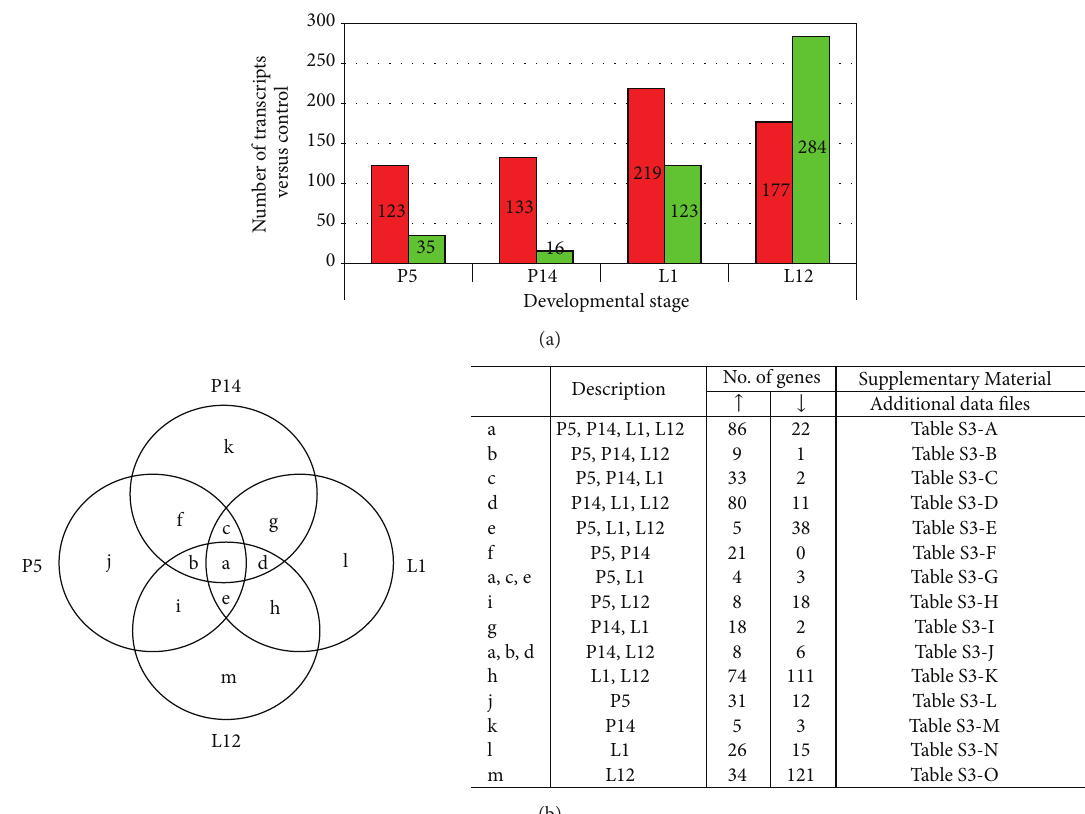
Figure 2: Overview of gene expression during mammary development through early pregnancy to mid-lactation. (a) Number of altered transcripts of each developmental stage versus a virgin stage (fold change ( z -score) > 1.5). Low expression is represented by green and high expression is represented by red. (b) Venn diagram and representative table illustrating the number of significant altered gene transcripts and overlaps among different reproductive